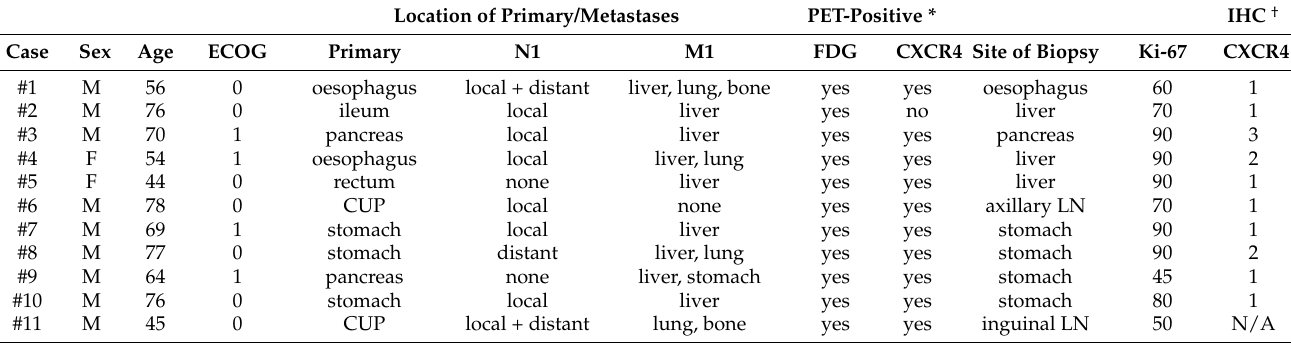
Table 1. Patient characteristics. All subjects were treatment-naive at timepoint of imaging/biopsy. * at any site; † IHC scoring system: 0 = negative, 1 = weak, 2 = moderate, 3 = strong; Age in years; CUP, cancer of unknown primary; CXCR4, CXC-motif chemokine receptor 4; ECOG, Eastern Cooperative Oncology Group; F, female; FDG, fluorodeoxyglucose; IHC, immunohistochemistry; Ki-67, proliferation index in [%]; N1, Nodal; LN, lymph node; M1, Metastasis; M, male and PET, positron emission